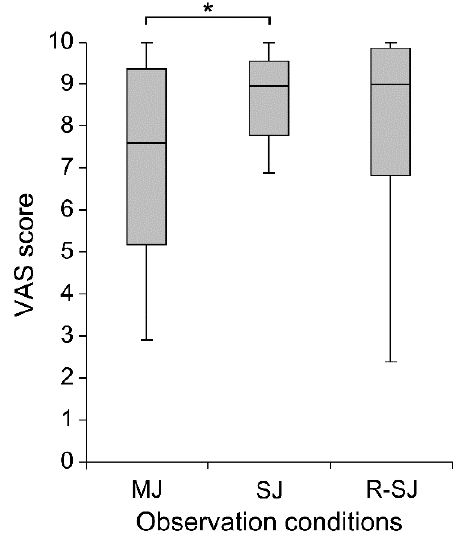
Figure 4. The visual analog scale (VAS) scores evaluating the degree of attention during individual observation conditions (MJ, SJ, and R-SJ) in compliance with the instructions. * p < 0.05. MJ, multiple-joint; SJ, single-joint; R-SJ, restricted single-joint.